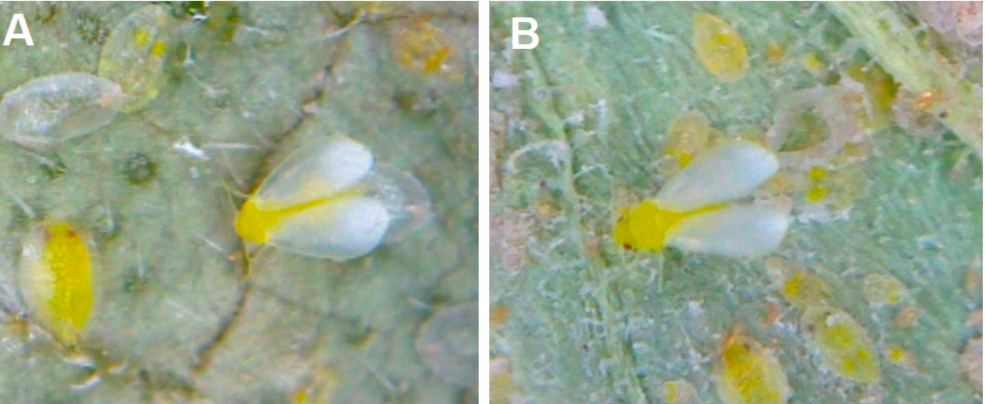
Figure 2. Adult of B. tabaci that were recently emerged from pupae that were developed on ToLCNDV-ES-infected zucchini ( A ) and tomato ( B ) leaves.